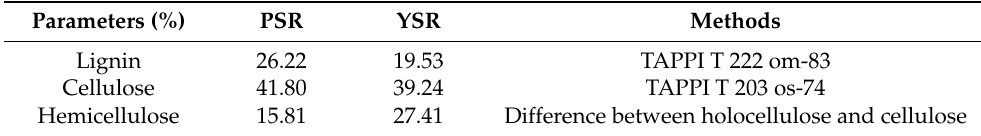
Table 3. Bromatological analysis of residual plantain and yam biomasses. Parameters